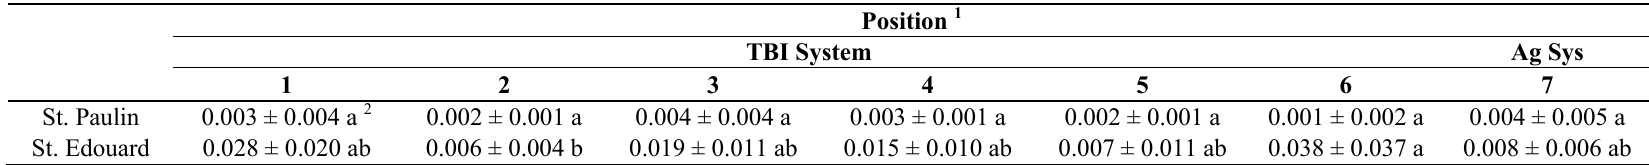
Table 6. Cumulative carbon content (kg C m − 2 ) of litterfall collected from July–October, 2012, in tree-based intercropping (TBI) systems and adjacent agricultural systems (Ag Sys) at St. Edouard and St. Paulin, southern Quebec, Canada. Values are the mean ± standard deviation ( n =